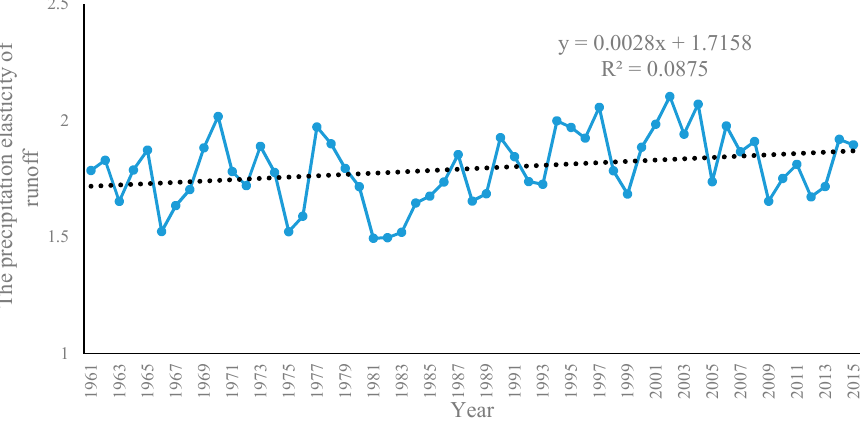
Figure 6. Changing trend of the precipitation elasticity of runoff.